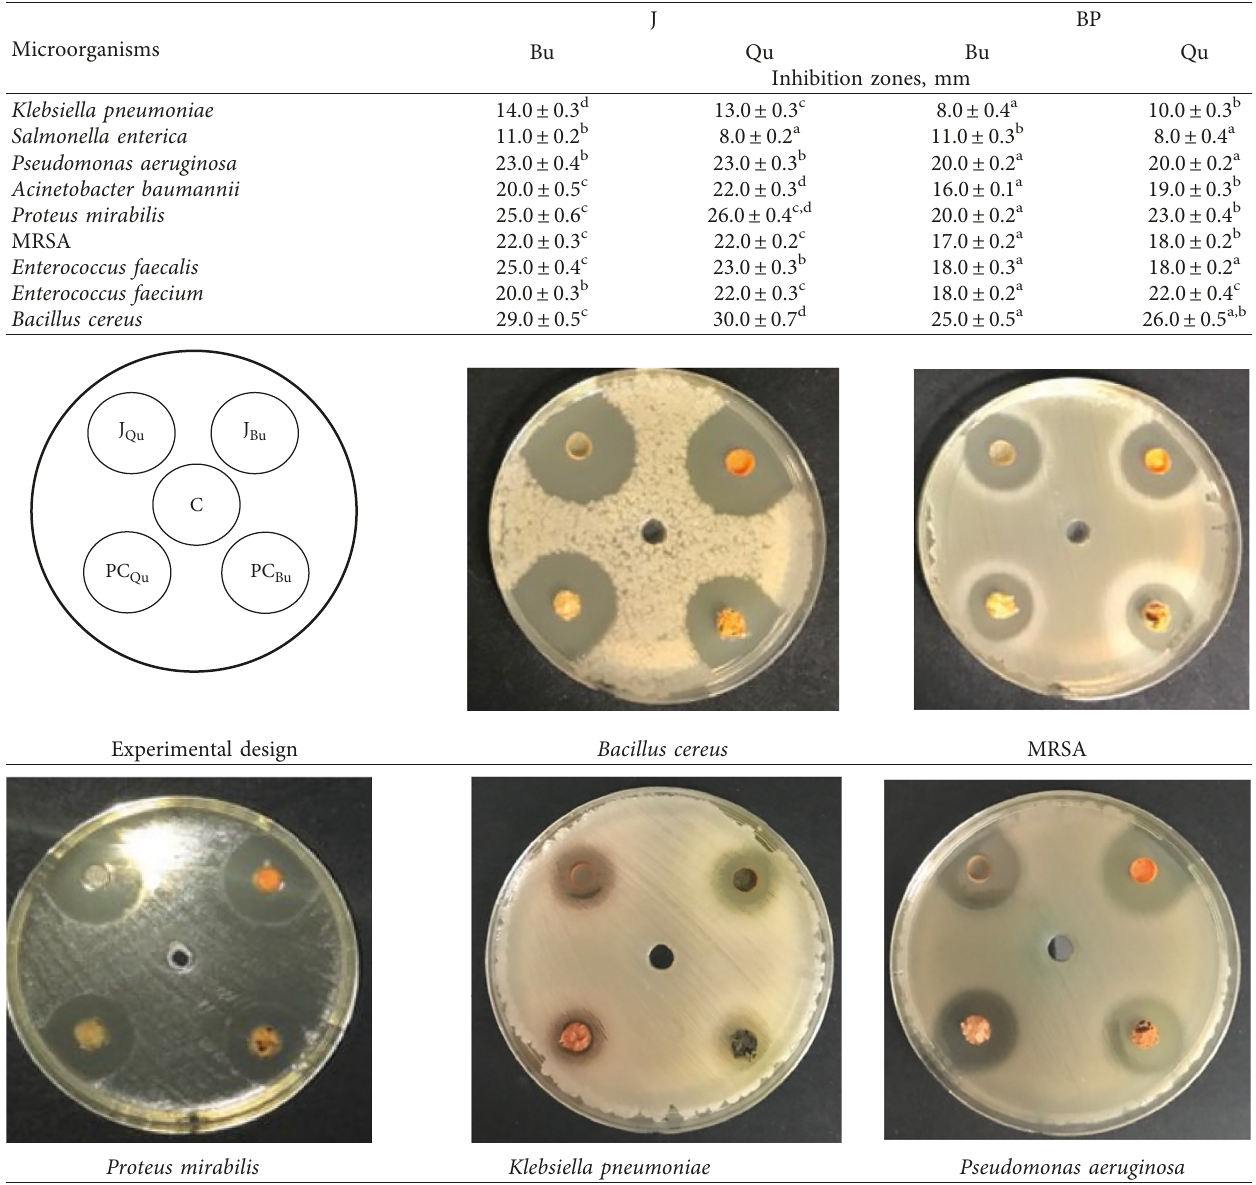
Table 2: Antimicrobial activity of buckthorn and quince juices and their 363 by-products.